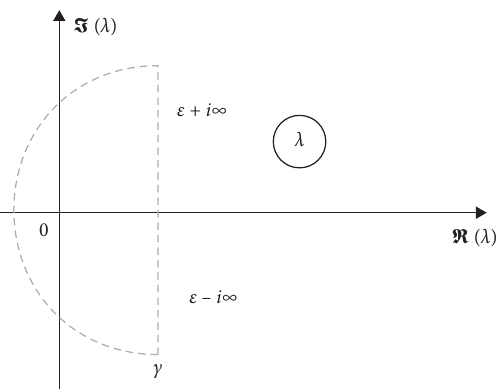
Figure 3: Contour for inversion of Laplace